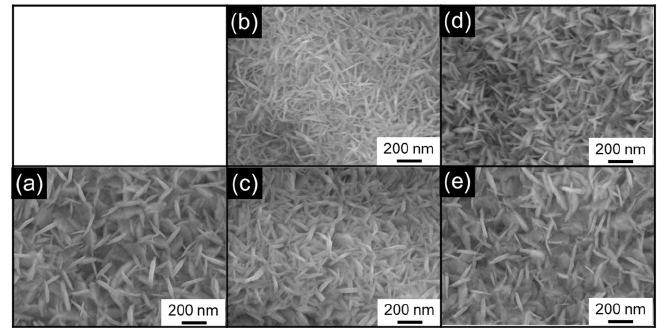
Figure 3. SEM images showing surfaces of specimens subjected to steam coating under different conditions: ( a ) 160 °C for 1 h; ( b ) 170 °C for 0.5 h; ( c ) 170 °C for 1 h; ( d ) 180 °C for 0.5 h; ( e ) 180 °C for 1 h.